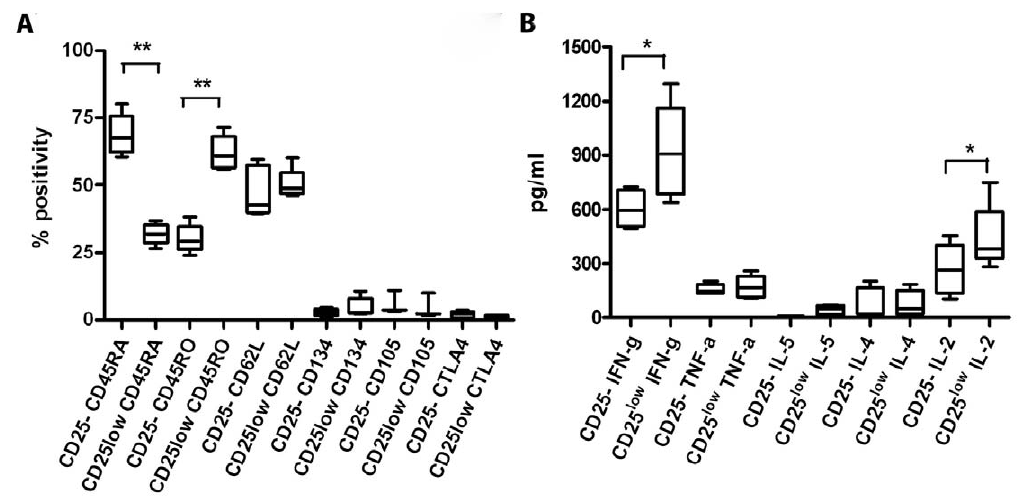
Figure 2. Analysis of surface molecules and cytokine production by sorted T cells. Presented are median values for expression of A) surface molecules and production of B) cytokines in both CD4 + CD25- and CD4 + CD25 low T cells. Aliquots were incubated with appropriate flurochorome- tagged antibody for surface markers CD45RA, CD45RO, CD62L, HLA DR, CD69 and HLA DQand analyzed by FACS (n=6). Statistically significant difference in expression was reached for CD45RA, CD45RO, HLA DR and CD69 (Mann-U-Whitney test, p=0.0022, p=0.0022, p=0.038 and p=0.0048, respectively). The cytokine production in CD4 + CD25- was significantly lower for IL-2 and IFN- c compared to CD4 + CD25 low T cell production of the same cytokines (p=0.027 and p=0.015, respectively, n=6). CD4 + CD25 low and CD4 + CD25 - T cells were cultured with 1 m g anti-human CD3 beads and 1xirradiated PBMC for 48 hours. Cytokines were measured using CBA assay. * - p , 0.05; ** - p , 0.005.